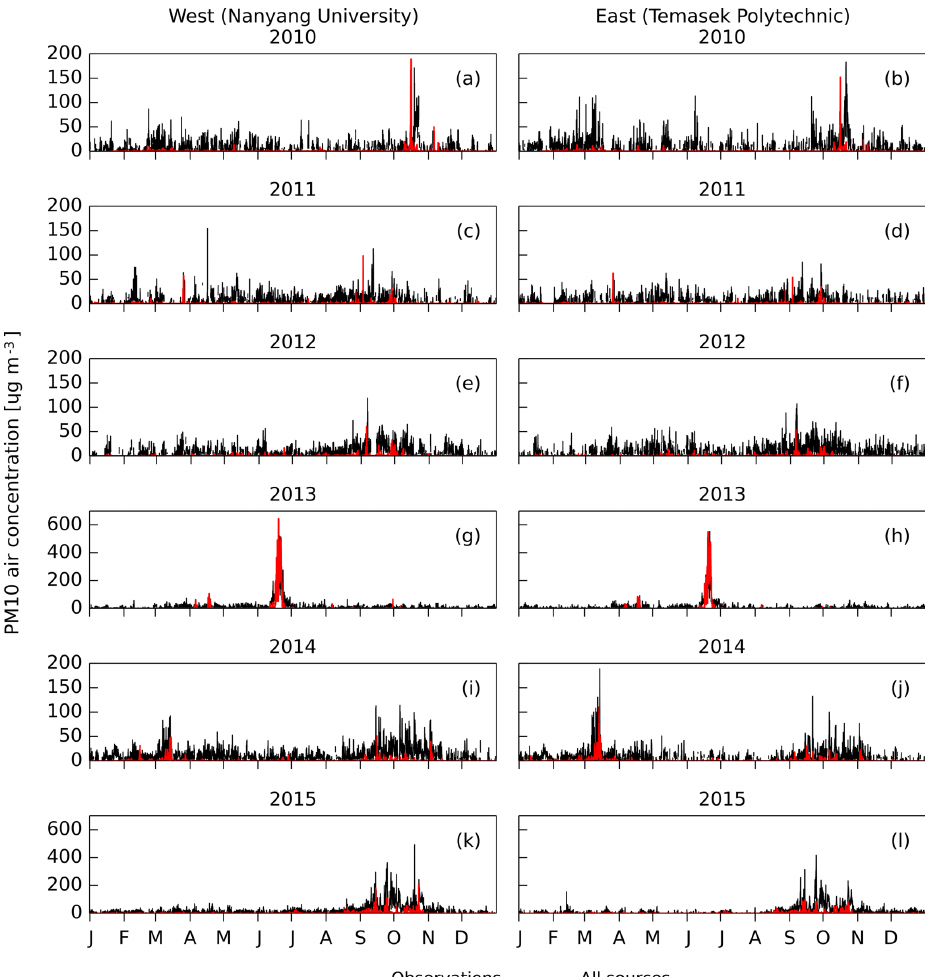
Figure 4. Modelled PM 10 time series (red line) with observations (black line) at each of the two monitoring stations west (NTU, left) and east (TP, right) for the six years with observations available, 2010 (top row) to 2015 (bottom row). A constant background concentration of 25µgm − 3 has been subtracted from the observations and any resulting negative values have been